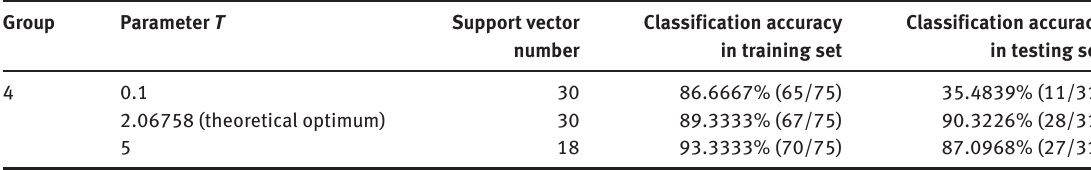
Table 7: The Classification Accuracy in the Fourth Group of Experimental Model. Group